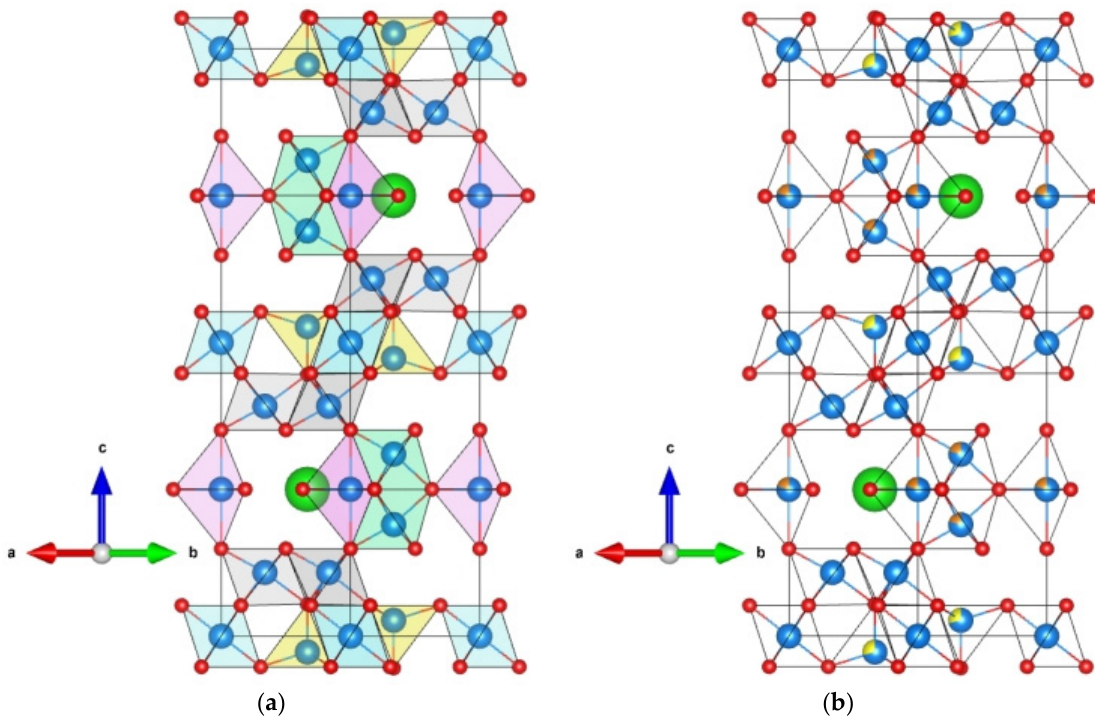
Figure 15. The hysteresis loop of BHF and Mg-Al doped BHF. Figure 15 shows that Mg-Al-doped BHF slightly increased the saturation magnetiza- tion. This effect can be evaluated by analyzing the effect of Mg-Al substitution on the crystal structure of BHF, as shown in Figure 16.